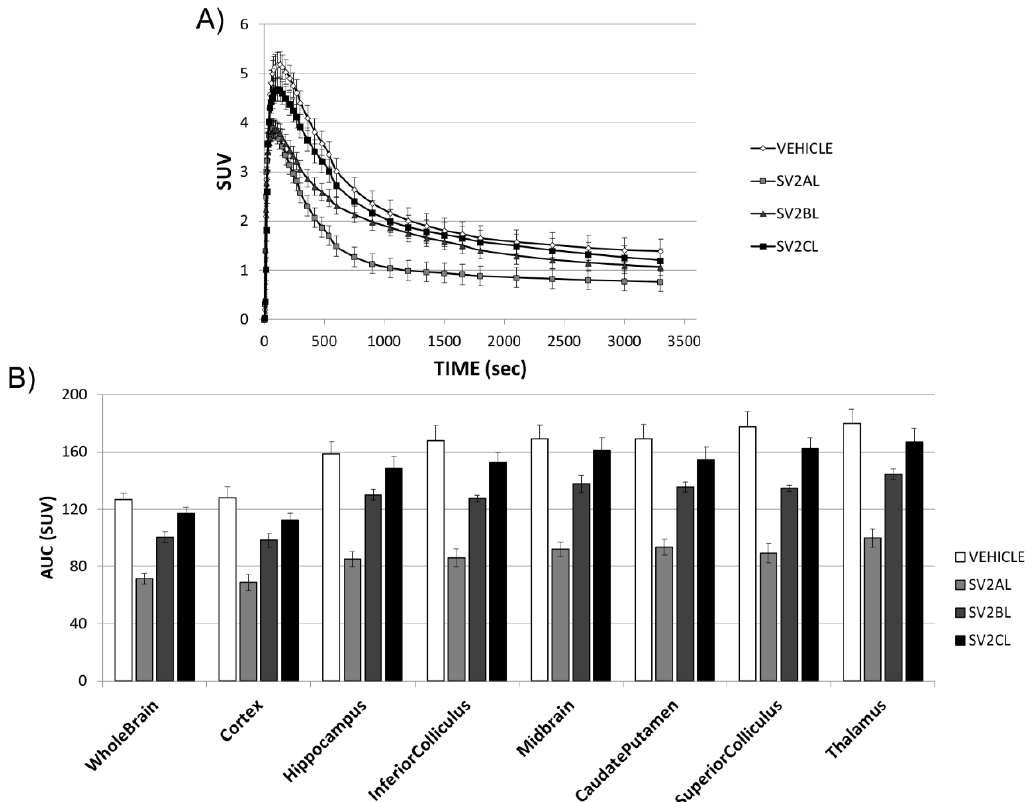
Figure 3. Representative time activity curves (TACs) and AUC (area under each TAC) for the different regions of interest (ROIs). ( A ) TACs extracted from the whole brain as ROI, and normalized by the injected activities and the body weight. Lines represent the [ 18 F]UCB-H uptake over a 60 min acquisition after pre-treatment with the vehicle, SV2A L , SV2B L , or SV2C L . ( B ) The bar plots represent the AUC in the eight ROIs (mean ± SEM, n = 5).